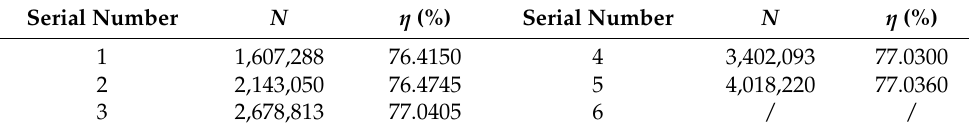
Figure 4. Grid diagram of each component. Table 2. Grid irrelevance analysis table (Forward running, Q = 400 L/s).